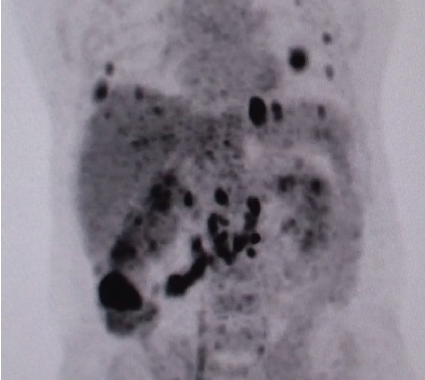
Figure 1: PETscan of the patient at the diagnosis of BRAF-mutant mCRC.